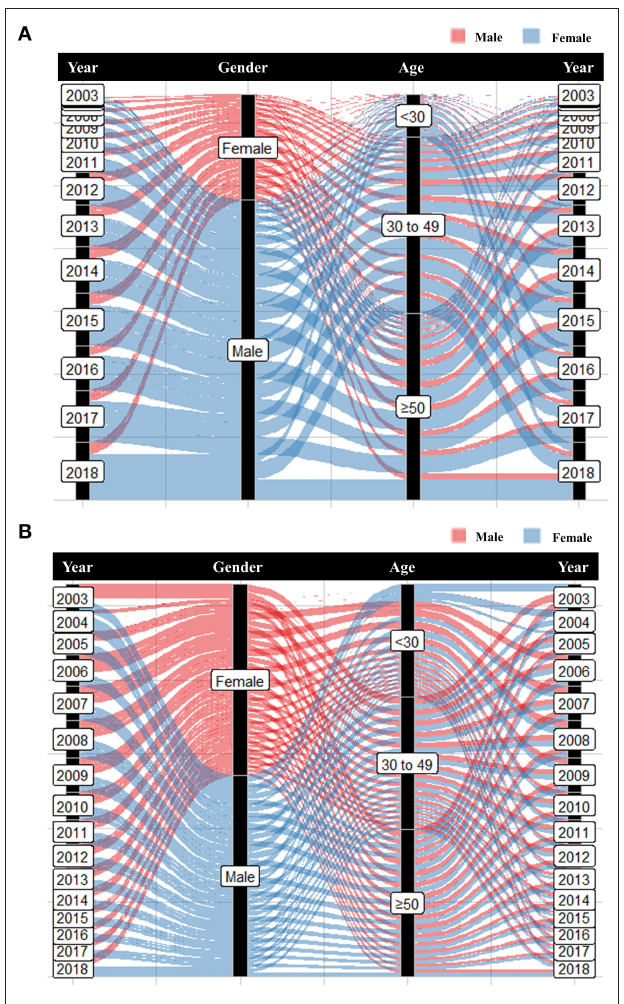
FIGURE 4 | The distribution of advanced HIV disease in age and gender in Hunan Province from 2003 to 2018. (A) The number of advanced HIV disease from 2003 to 2018; (B) Proportions of advanced HIV disease from 2003 to